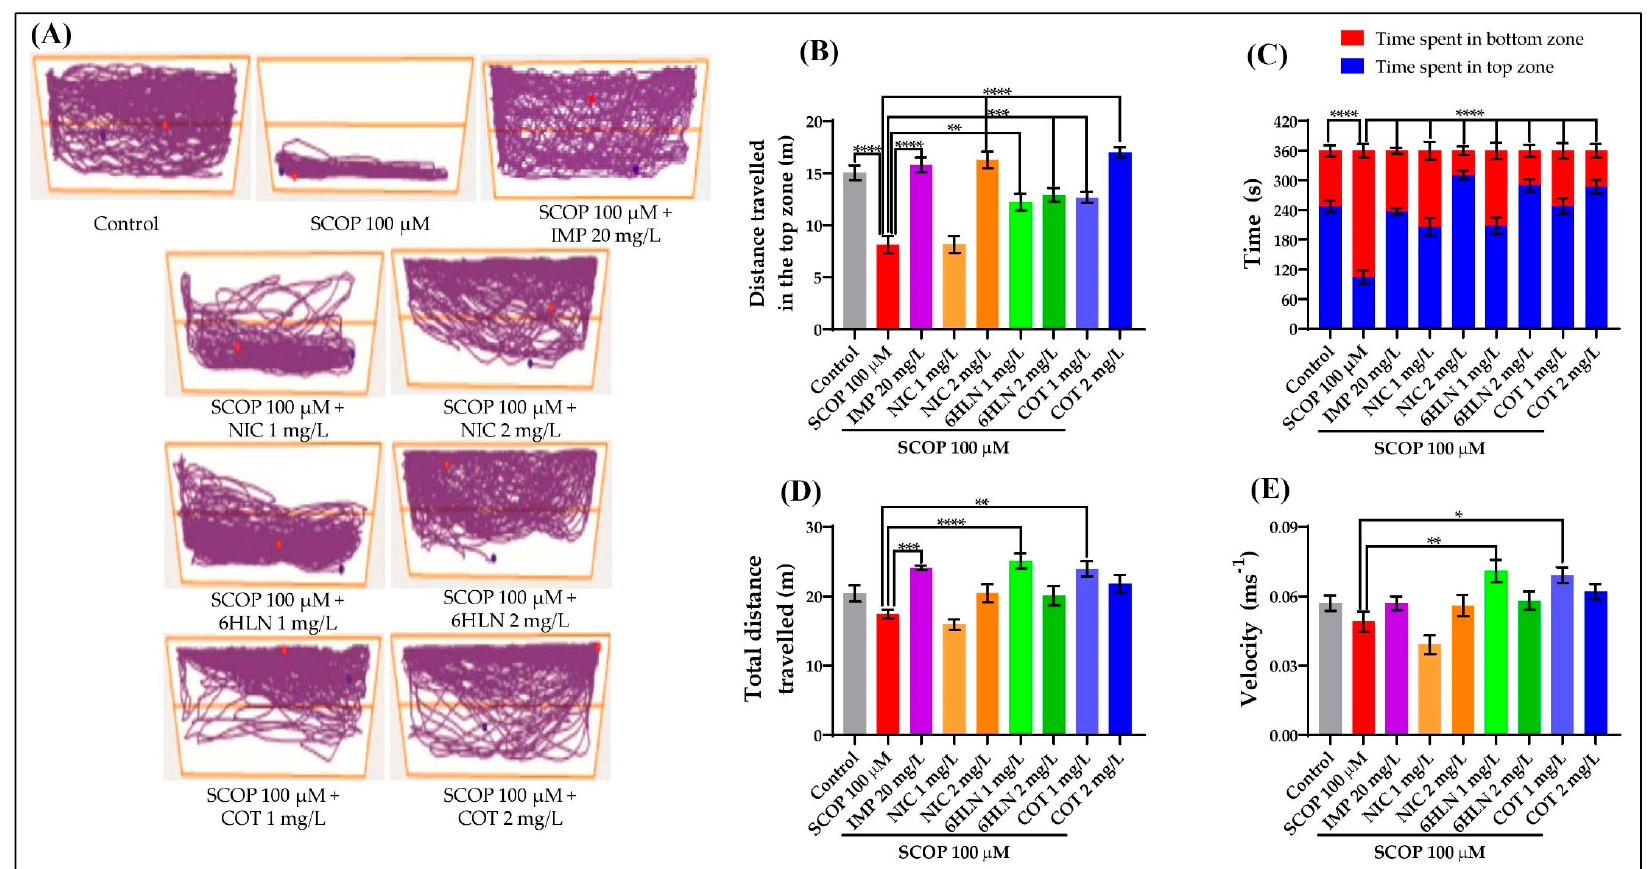
Figure 3. The effects of nicotine (NIC), 6-hydroxy-L-nicotine (6HLN), and cotinine (COT) (1 and 2 mg/L) administration in scopolamine (SCOP)-treated zebrafish on anxiety-like behavior and locomotor activity evaluated within the novel tank diving test (NTT). ( A ) The zebrafish locomotion tracking pattern in the NTT according to the experimental groups they belong to. The blue dot represents the beginning of the route while the red dot represents the end of the route. The distance travelled in the top ( B ) and the time spent in the top/bottom ( C ) were endpoints for measuring the anxiety, whereas the total distance travelled ( D ) and the velocity ( E ) were endpoints for measuring the locomotor activity. The values are expressed as means ± S.E.M. ( n = 10). ANOVA analysis identified overall significant differences between the experimental groups for ( B ) F(8,81) = 21.35, p < 0.0001, ( C ) F(8,162) = 42.29, p < 0.0001, ( D ) F(8,81) = 8.555, p < 0.0001 and ( E ) F(8,81) = 6.172, p < 0.0001. For Tukey posthoc analyses—**** p < 0.0001, *** p < 0.001, ** p < 0.01 and * p <